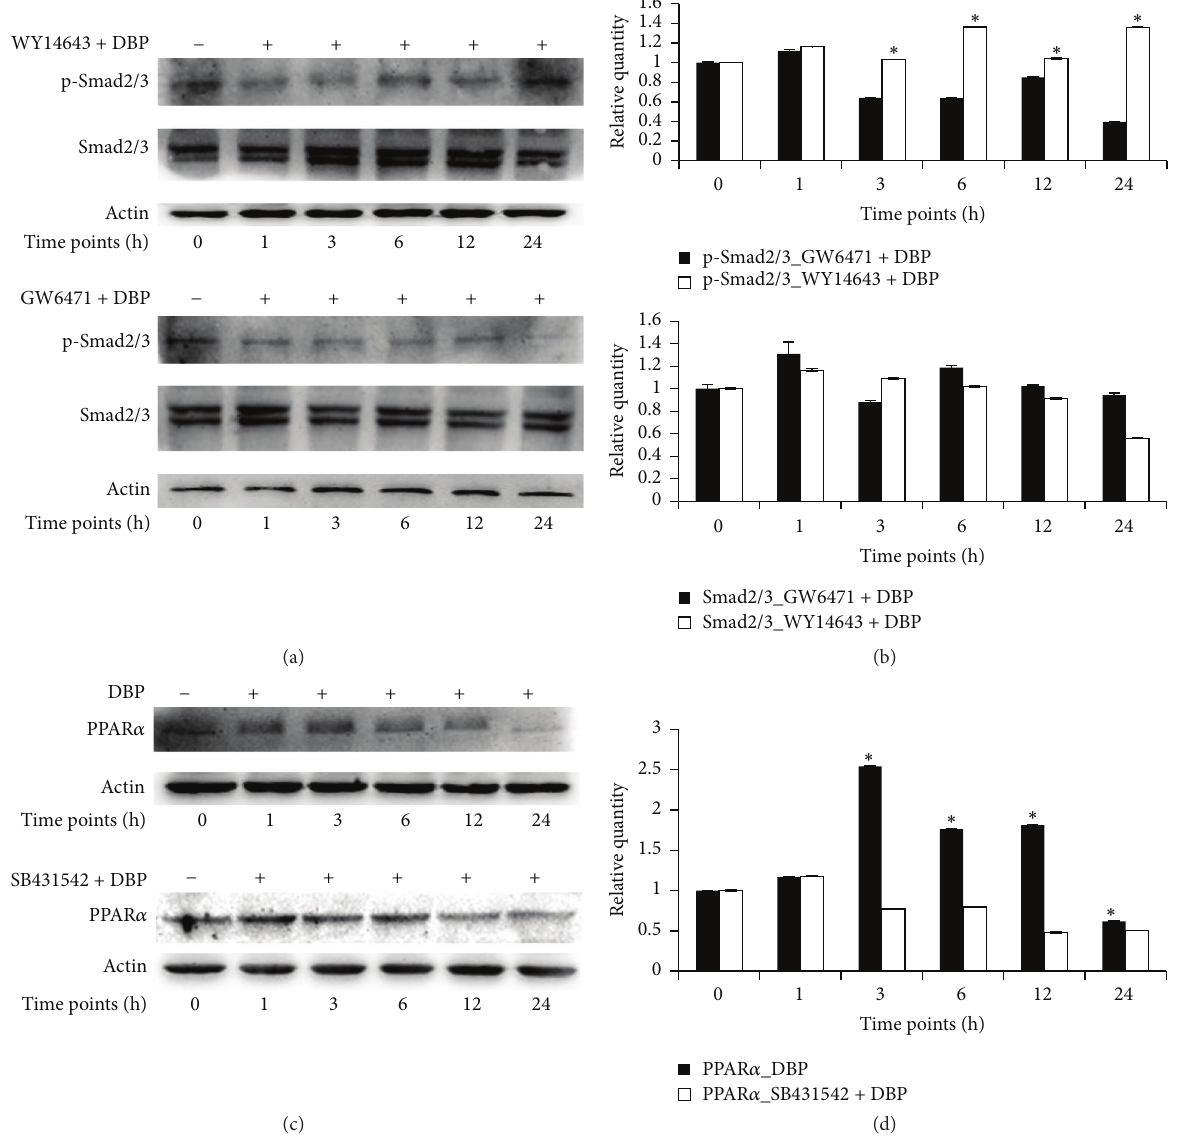
Figure 3: Relationship between PPAR 𝛼 and Smad2/3 in DBP-treated SCs. GW6471, WY14643, and SB431542 were added to the cultural medium 2h before addition of DBP, respectively. Western blotting was used to test levels of p-Smad2/3 and Smad2/3 in WY14643 + DBP- and GW6471 + DBP-treated SCs (as shown in (a)) and levels of PPAR 𝛼 in DBP- and SB431542 + DBP-treated SCs, respectively (as shown in (c)). (b) and (d) show the relative quantitative analysis of parts (a) and (c), respectively. 𝑃 < 0.05 was considered statistically significant.